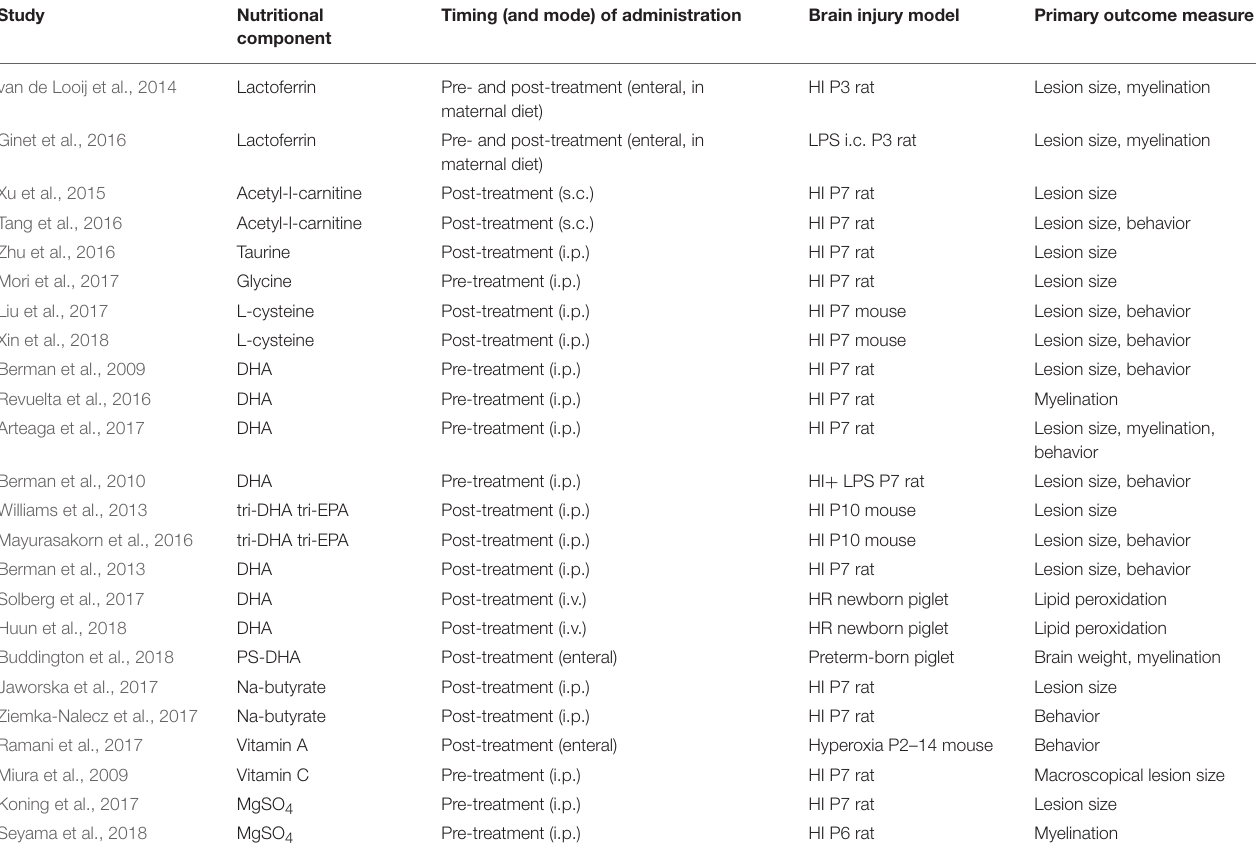
TABLE 1 | Baseline characteristics of included pre-clinical